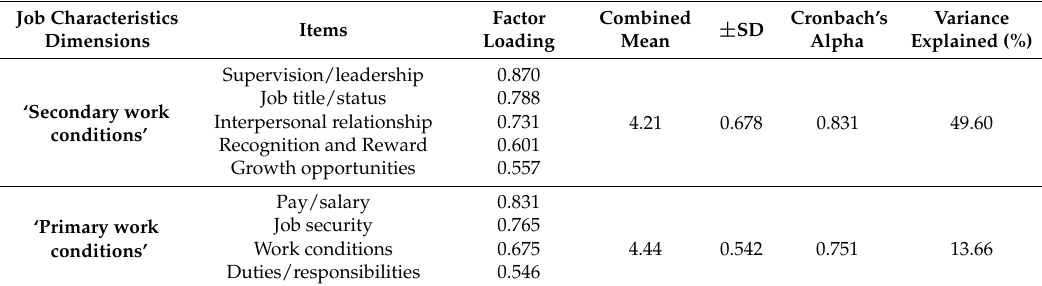
Table 3. Factor analysis—job characteristics versus work